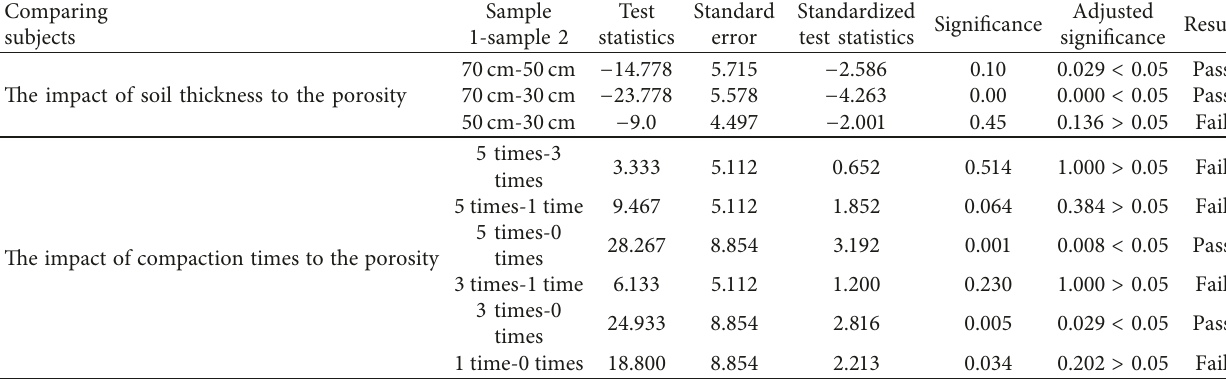
Table 4: Results of multiple comparison